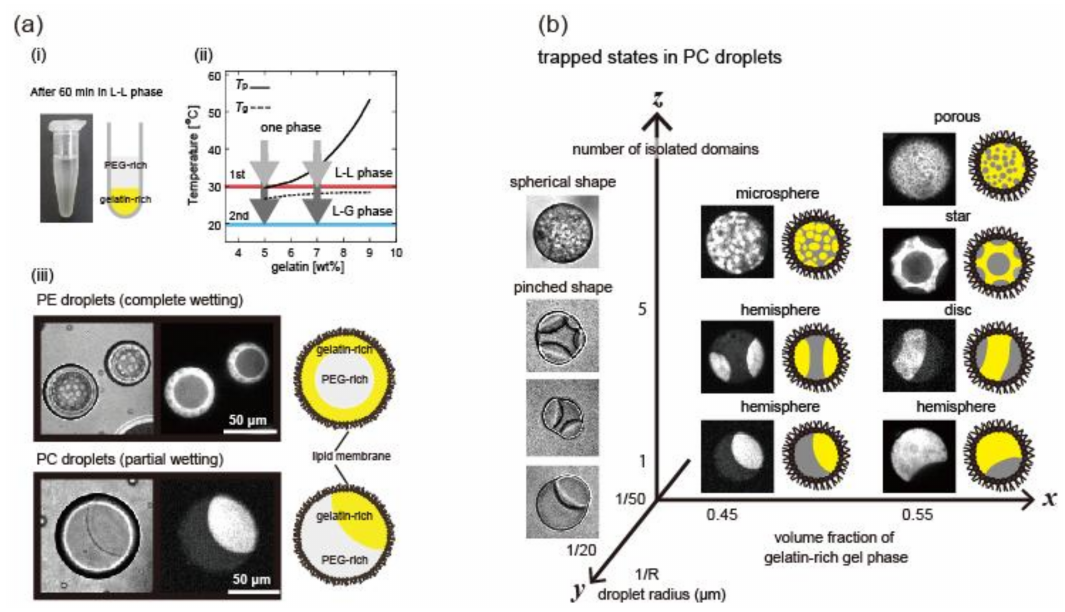
Figure 2. Morphology control using phase separation and gelation of gelatin inside microdroplets. ( a ) ( i ) An example of phase-separated solution of poly-(ethylene glycol) (PEG)1.7 wt % and gelatin 5.0 wt % in tube; ( ii ) Schematic phase diagram of PEG/gelatin blends containing the PEG 1.7 wt % and various concentrations of gelatin. The black solid and dashed lines indicate the phase separation point, T p and the gelation point, T g, respectively; ( iii ) Phase separation of PEG and gelatin 5.0 wt % blend in phosphatidylethanolamine (PE) and phosphatidylcholine (PC) droplets after 60 min incubation. Droplets are shown in (from left to right) differential interference contrast (DIC) images, fluorescent images of the gelatin-rich gel phase and schematic illustrations. ( b ) Variously shaped microgels in PC droplets in response to changes in volume fraction of gelatin-rich phase, droplet size and number of isolated domains. In the x – z plane, large droplets with R ~50 µ m are shown in fluorescent images and schematic illustrations, where gelatin-rich phase is shown in white and yellow, respectively. In the y – z plane, small droplets with R ~20 µ m are shown as DIC images. (M. Yanagisawa et al., Copyright 2014, National Academy of